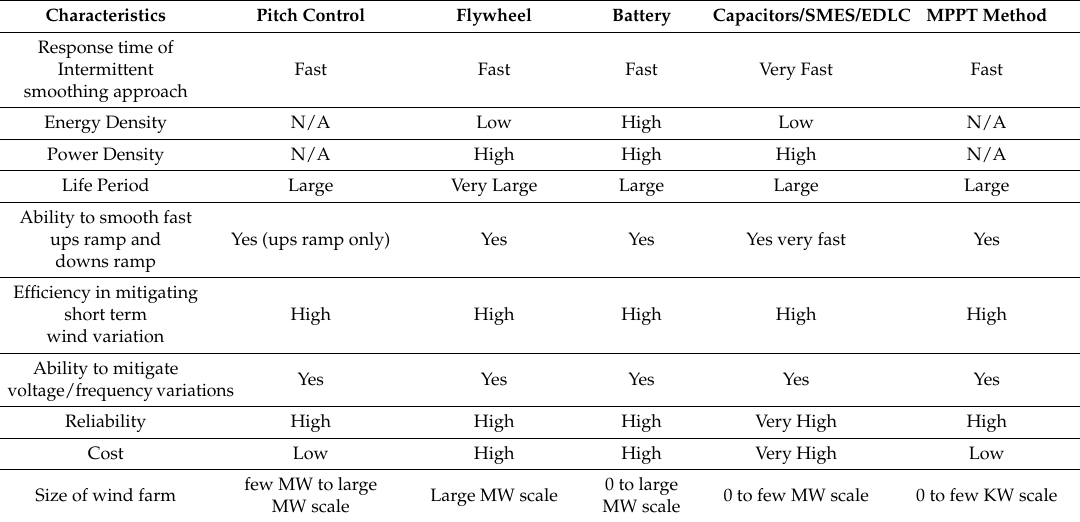
Table 1. Comparison of characteristic features among different intermittent smoothing approaches for mitigating wind power